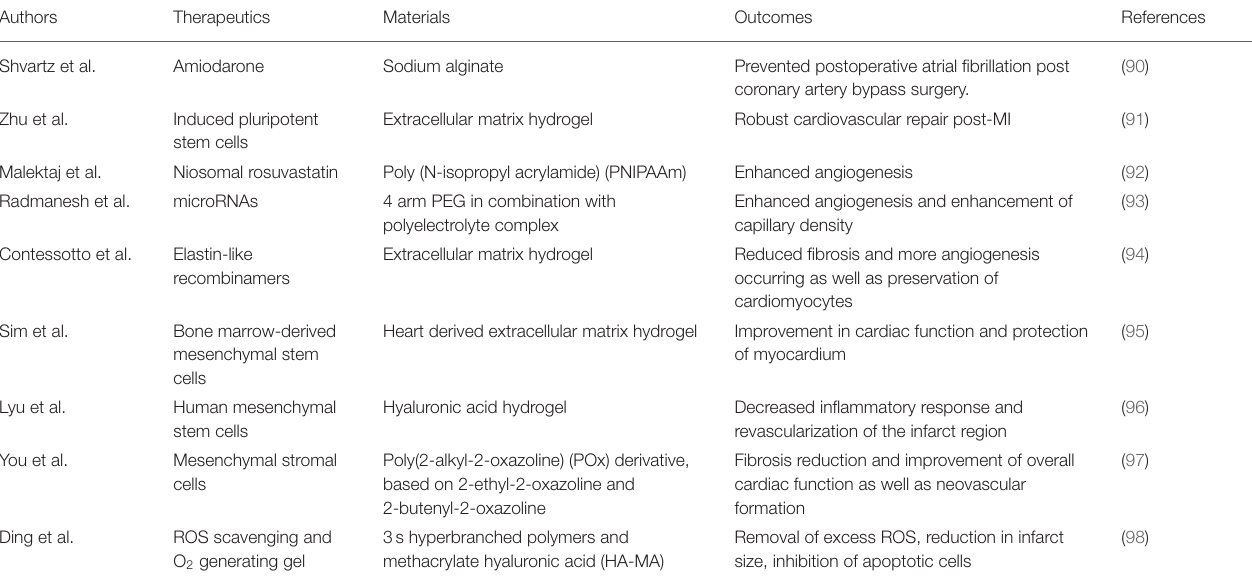
TABLE 3 | Studies highlighting the hydrogel formulations used to delivering cells, miRNA, small molecules and growth factors for cardiac